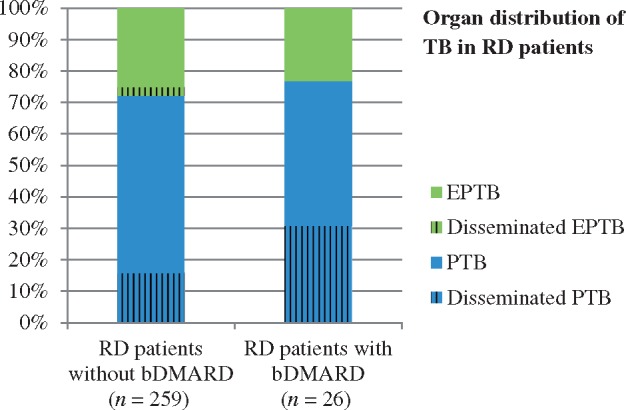
Organ distribution of tuberculosis in rheumatic disease patients (expressed as a percentage)No statistically significant difference appeared in the organ distribution of TB in patients without bDMARDs and in patients taking such drugs. bDMARD: biological DMARD; EPTB: extra-pulmonary tuberculosis; PTB: pulmonary tuberculosis; RD: rheumatic disease; TB: tuberculosis.